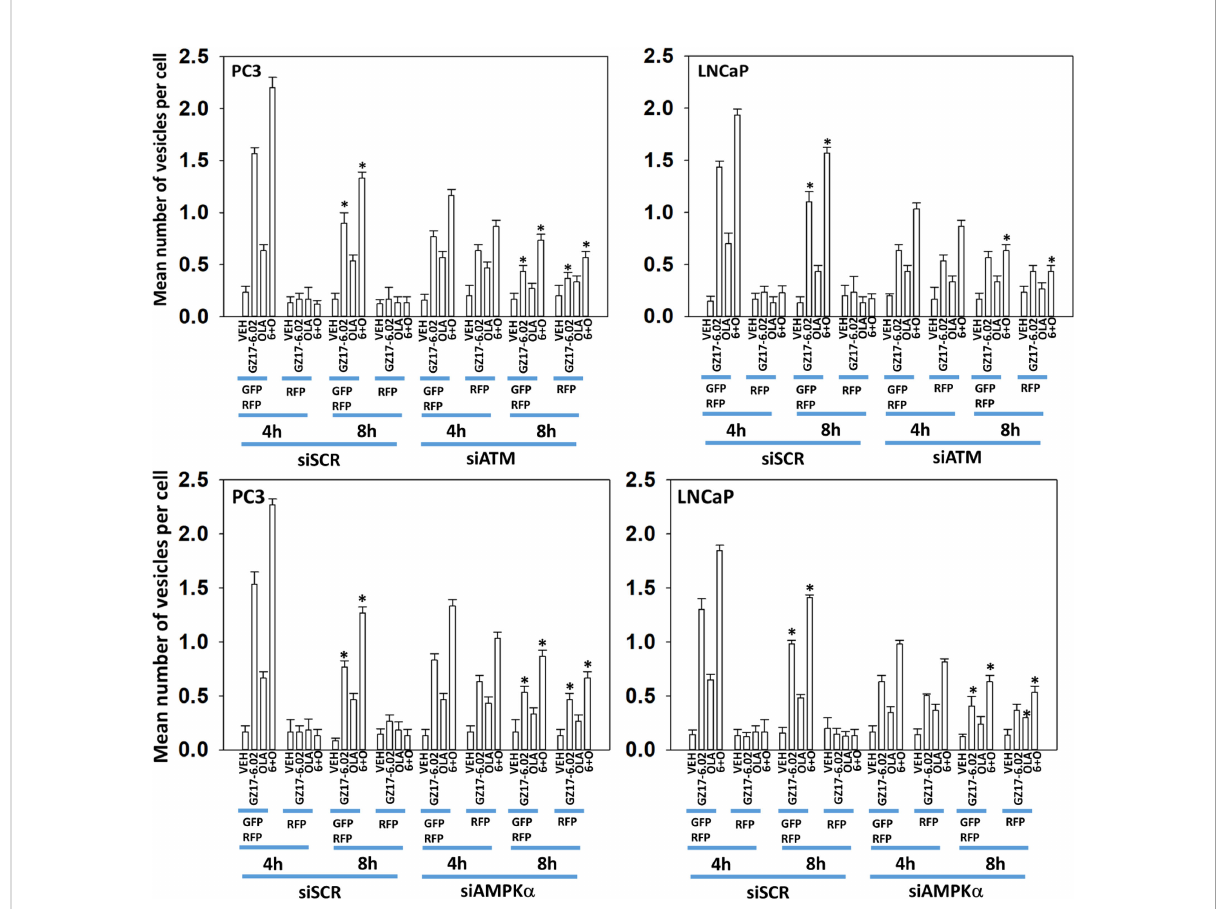
FIGURE 3 Knock down of ATM reduces autophagosome formation and autophagic fl ux. PC3 and LNCaP cells were transfected with a plasmid to express LC3-GFP-RFP and in parallel transfected with a scrambled siRNA or with siRNA molecules to knock down the expression of ATM or of AMPK a . Twenty-four h later, cells were treated with vehicle control, GZ17-6.02 (2 m M), olaparib (50 nM) or the drugs in combination for 4h and 8h. At each time point, the mean number of GFP+RFP+ and only RFP+ vesicles per cell were determined (n = 3 +/-SD). * p < 0.05 less than corresponding value in siSCR transfected